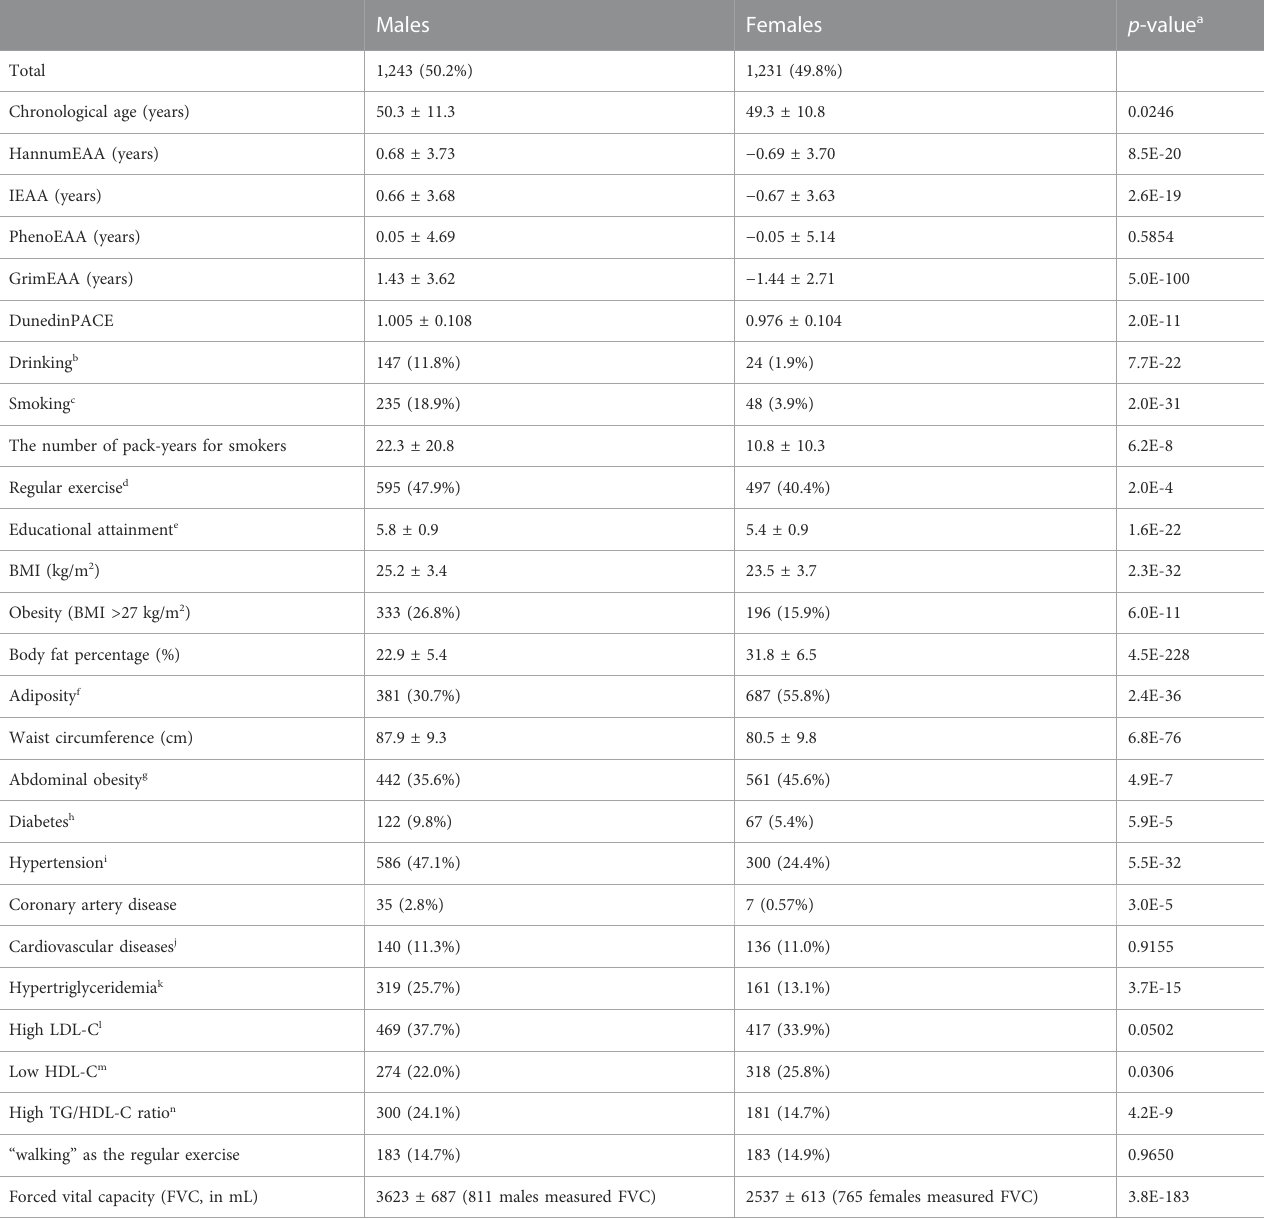
TABLE 1 Basic characteristics of the 2,474 TWB participants. Males Females p -value